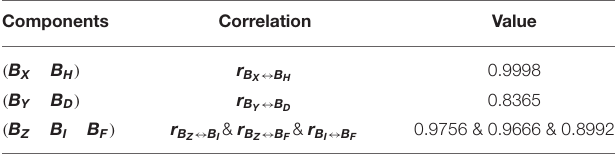
TABLE 1 | The correlation statistical results of geomagnetic parameters.